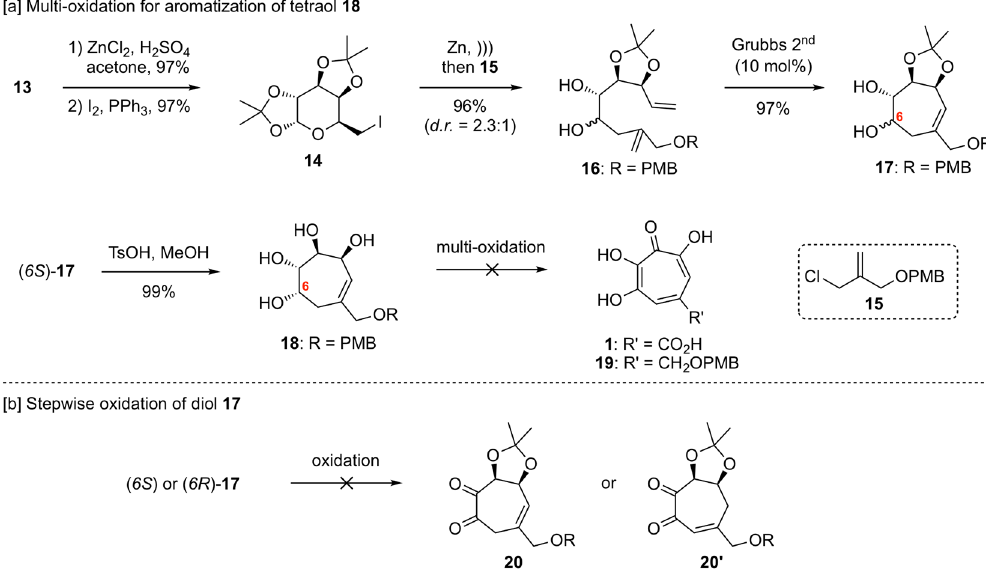
Figure 3. Oxidation of hydroxyl groups on the 7-membered